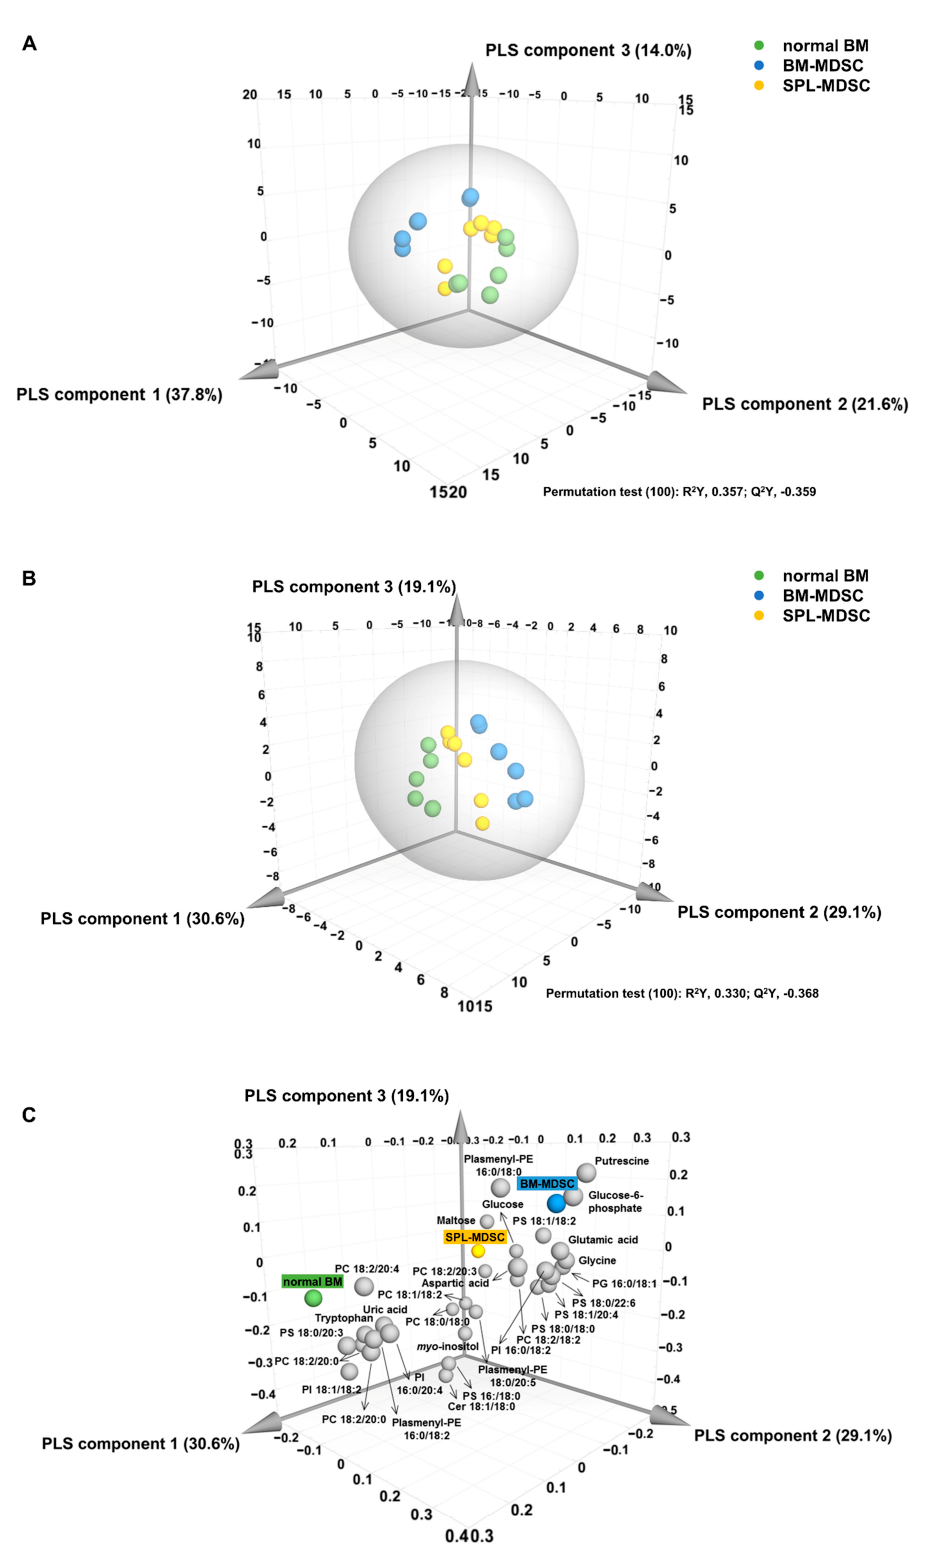
Figure 3. PLS-DA analysis. PLS-DA analysis from metabolomic and lipidomic profiling data for BM cells and MDSCs. ( A ) PLS-DA score plot. ( B ) Regenerated PLS-DA score plot based on components with high VIP values over 1.0. ( C ) PLS-DA loading plot derived from metabolomic and lipidomic profiling data for normal BM, BM-MDSCs, and